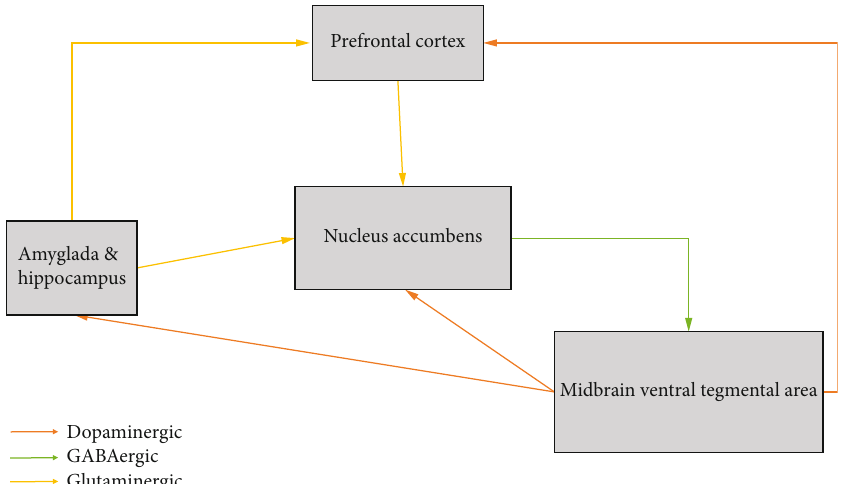
Figure 1: Diagram outlining key components of reward circuits of the midbrain. Nicotine administration activates midbrain dopaminergic pathways